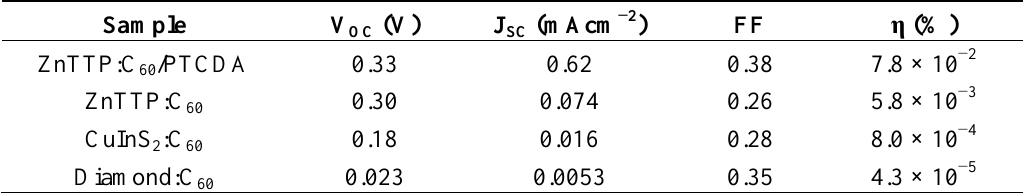
Table 1. Measured parameters of the present solar